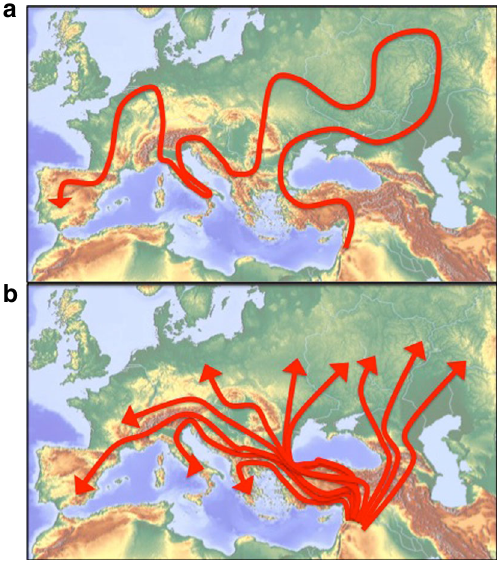
Fig. 8 Alternative models of Moderns ’ spatial trajectory in